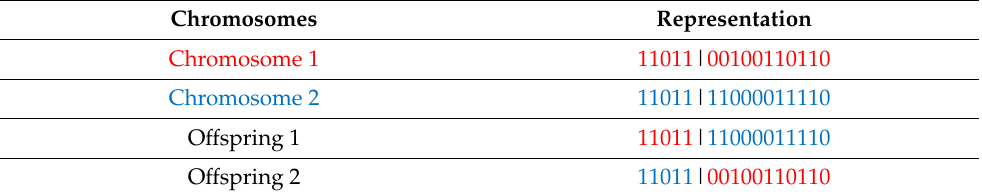
Table 2. Chromosome representation in the algorithm used.